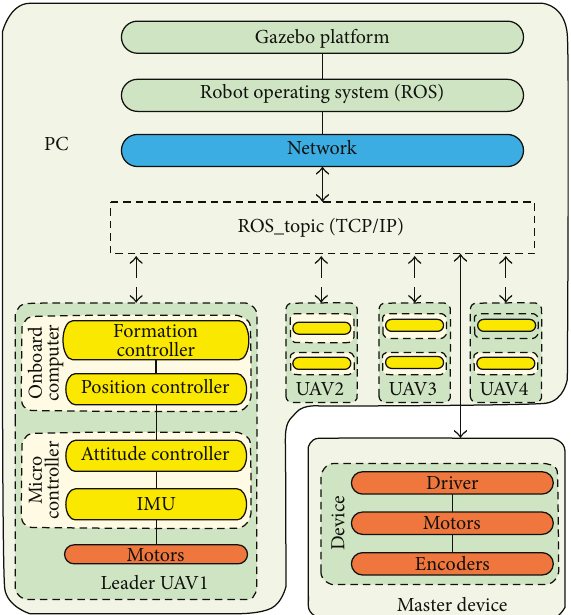
Figure 12: The framework of the experimental setup.